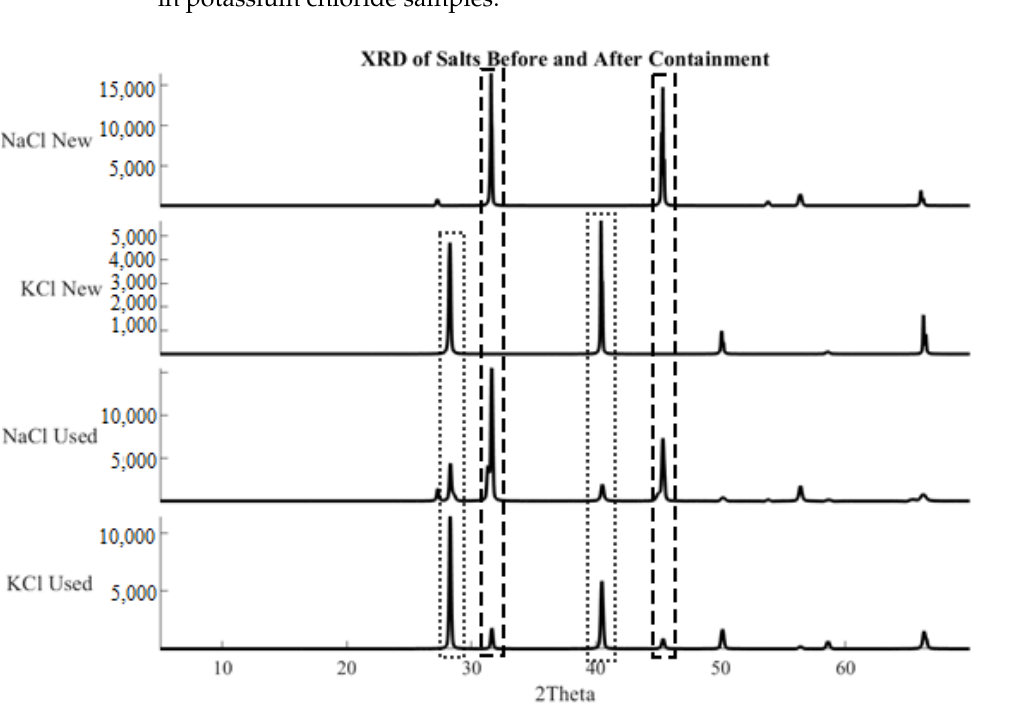
Figure 8. Bulk ASH-G composite after heating to 805 °C for 240 h with NaCl ( A ) and heating to 775 °C for 240 h with KCl ( B ). No microcracks are present.